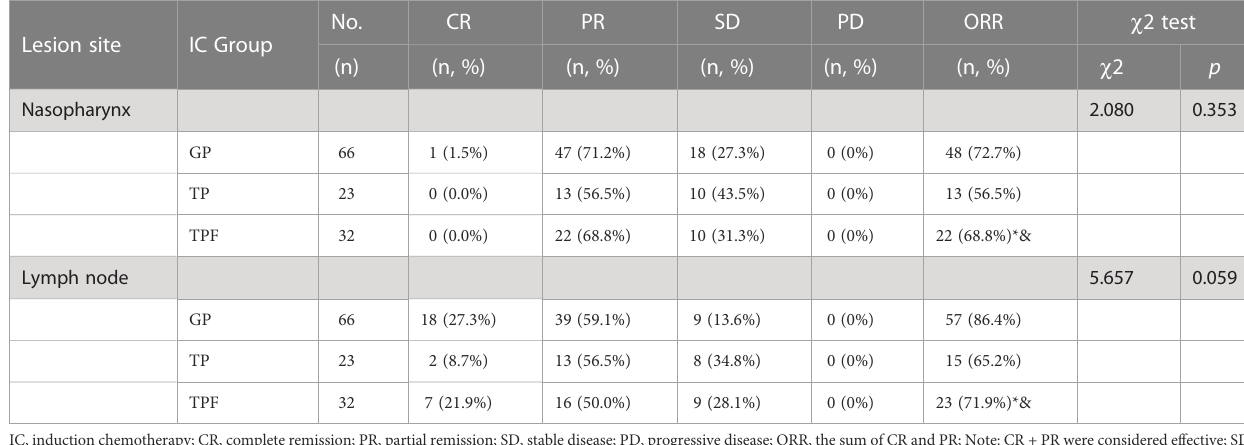
TABLE 4 Subgroup analysis by the speci fi c chemotherapy regimens.